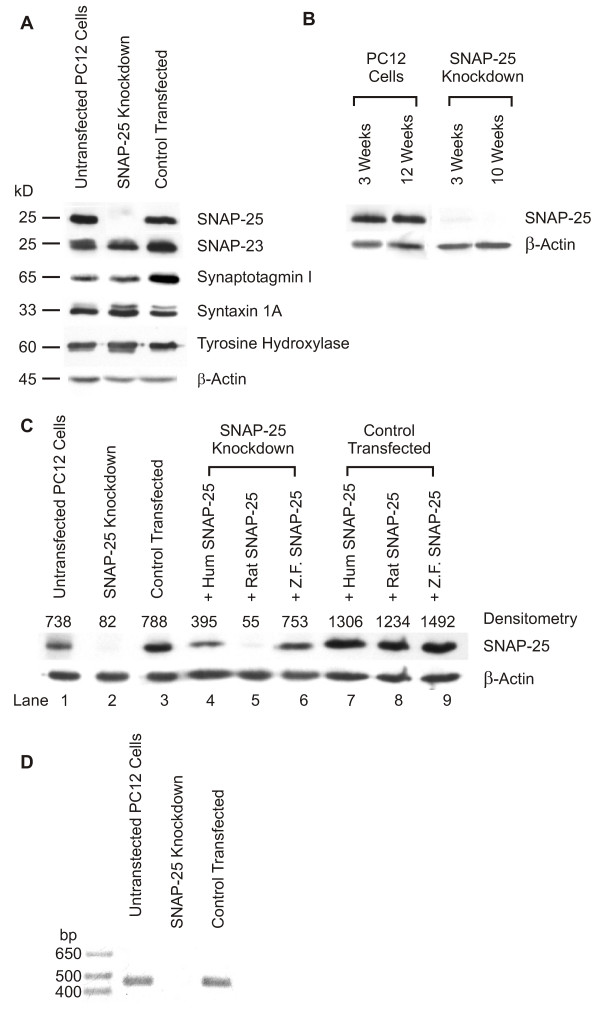
Specific silencing of SNAP-25 by RNA interference. A) Immunoblots were done to assess the levels of SNAP-25, SNAP-23, synaptotagmin I, syntaxin 1A, tyrosine hydroxylase and β-actin in wild type PC12 cells, SNAP-25 knockdown cells and in control transfected cells (PC12 cells stably transfected with pG418-shRNA lacking an shRNA insert). Equal amounts of protein were loaded per lane. B) The SNAP-25 phenotype is maintained for at least 10 weeks in culture in both the parent PC12 cell line and the SNAP-25 knockdown cell line. C) Human and zebrafish SNAP-25 mRNAs are resistant to RNA interference. The specificity of the SNAP-25 shRNA was demonstrated by transiently transfecting SNAP-25 knockdown cells with plasmids designed to express SNAP-25 cDNA of rat, human, or zebrafish origin. The 19 nucleotide region of rat SNAP-25 mRNA which is targeted by the SNAP-25 shRNA differs from human SNAP-25 RNA at only 2 positions and from zebrafish SNAP-25 mRNA in 4 positions. The immunoblot shows that expression of rat SNAP-25 was silenced in the SNAP-25 knockdown cells, but human and zebrafish SNAP-25 were expressed. All three SNAP-25 cDNAs appeared to be expressed in the control transfected cells in that there was more SNAP-25 in the control transfected cells than in untransfected PC12 cells. The immunoblot was stripped and reprobed for β-actin to demonstrate approximately equal amounts of protein in each sample. D) SNAP-25 mRNA is reduced in SNAP-25 knockdown cells. RT-PCR was carried out with RNA isolated from wild type PC12 cells, SNAP-25 knockdown cells and in control transfected cells. SNAP-25 mRNA was easily detected in wild type and control transfected PC12 cells, but no SNAP-25 mRNA was detected in the SNAP-25 knockdown cells in this PCR experiments. However, if more of the reverse-transcription product was used for the PCR or if more cycles were done in the PCR reaction, some SNAP-25 mRNA was detectable in the SNAP-25 knockdown cells.